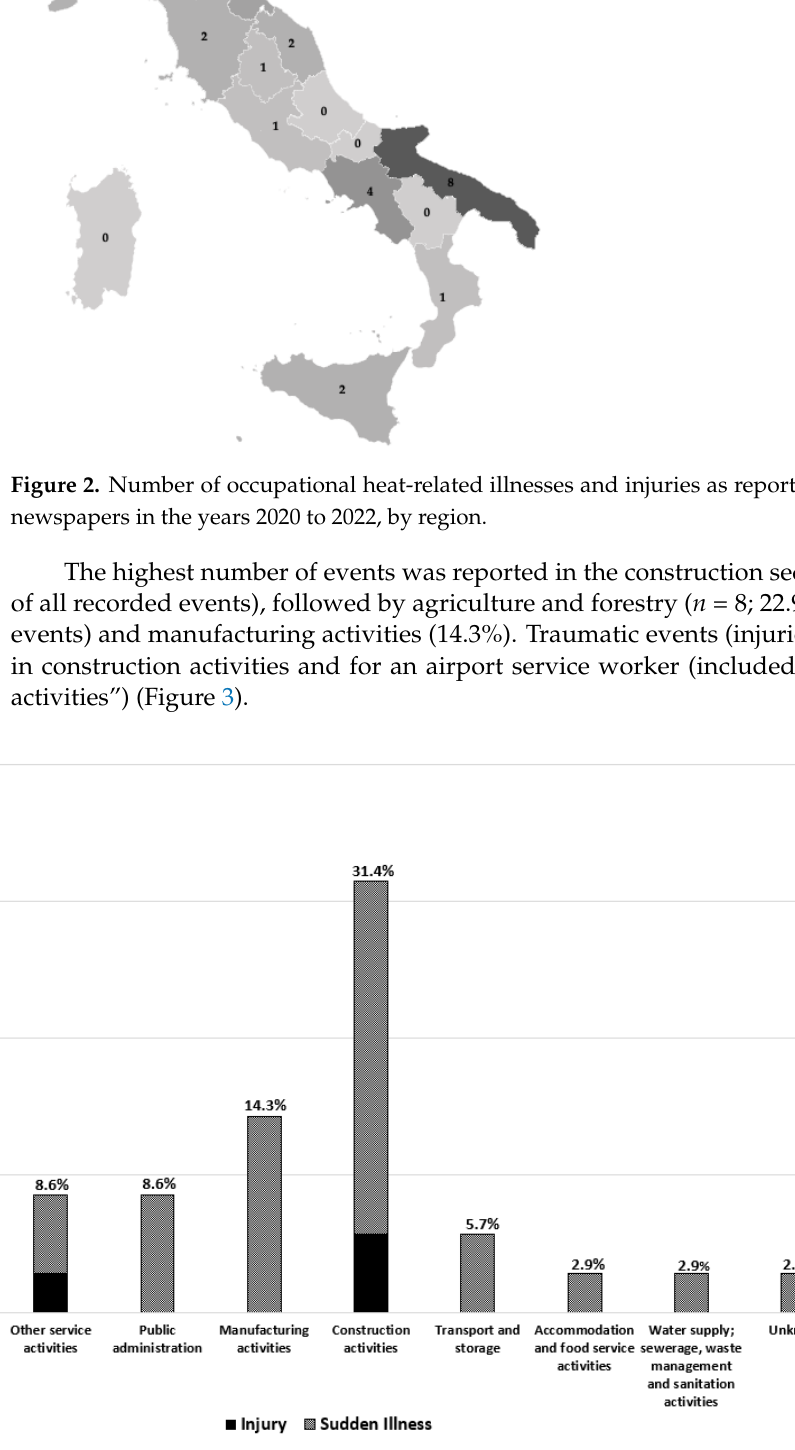
Figure 3. Number of occupational heat-related illnesses and injuries as reported by Italian online newspapers in the years 2020 to 2022, by occupational sector.